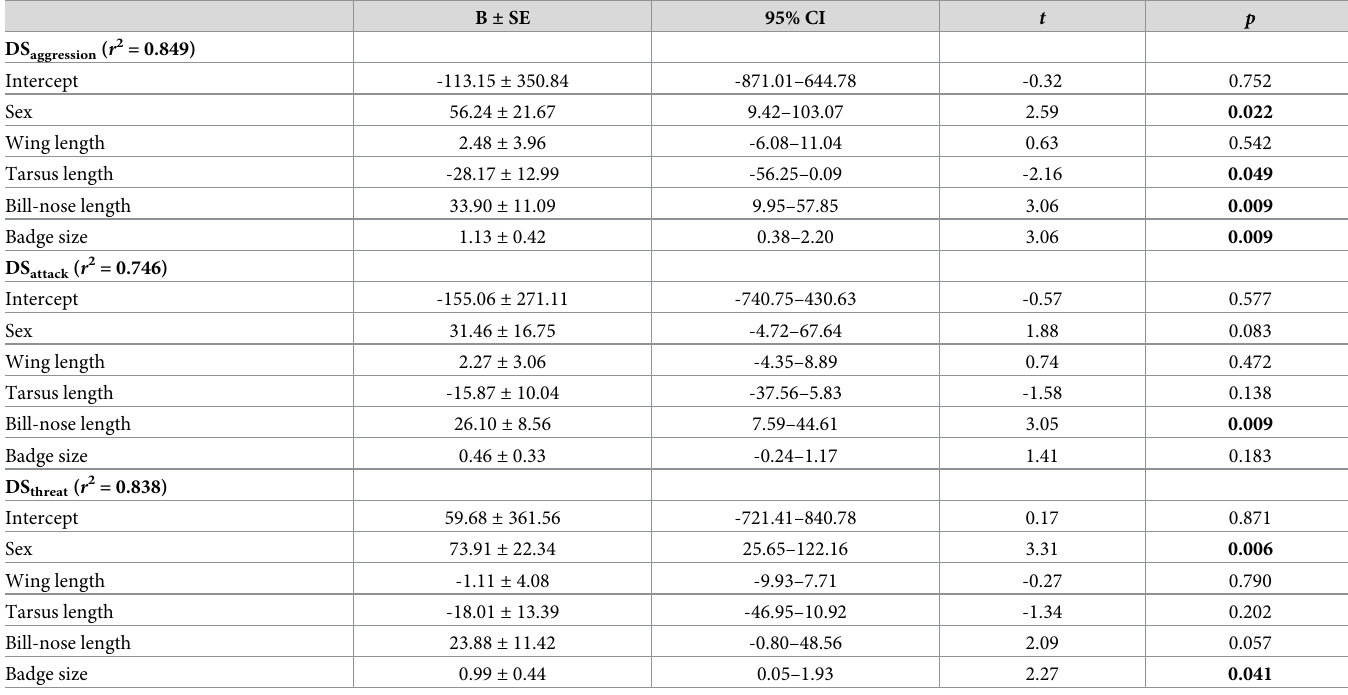
are common, especially in social birds living in groups. In this situation, the social system was evolved to reduce the cost by agonistic interaction [42, 43]. When foraging on feeding plates, threat displays and they established a dominance hierarchy based on the outcomes of aggres- sive behaviours. We found that morphological characteristics independently affected social status signalling, and it is likely to be important for organizing stable society to mediate con- flicts in the tree sparrow flock. Social species frequently establish dominance hierarchies to prevent conflicts during com- petition for limited resources [9, 29, 42, 43] and the observed agonistic interactions of tree Table 3. Effects of morphological traits on the outcomes of aggressions, attacks, and threat displays in tree